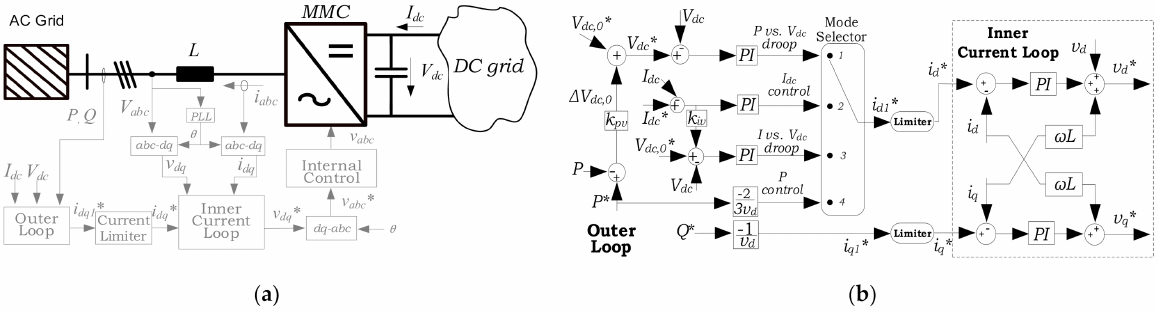
Figure 7. Control scheme of a grid-tied MMC. ( a ) Structure. ( b ) Outer and inner current